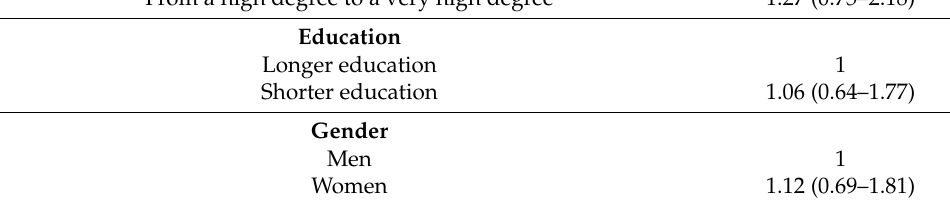
Table 2. Prevalence and odds ratio of barriers and facilitators of re-employment. Significant associa- tions are marked in bold. Factors for Returning to the Labour Market Odds Ratios (95 % CI *) Would You Like to Have a Job? From not at all to some degree 1 From a high degree to a very high degree 2.35 (1.14–4.85) Self-reported health Good (good to excellent) 1 Poor (fair to poor) 0.32 (0.16–0.61) Age 50–54 years 1 55–59